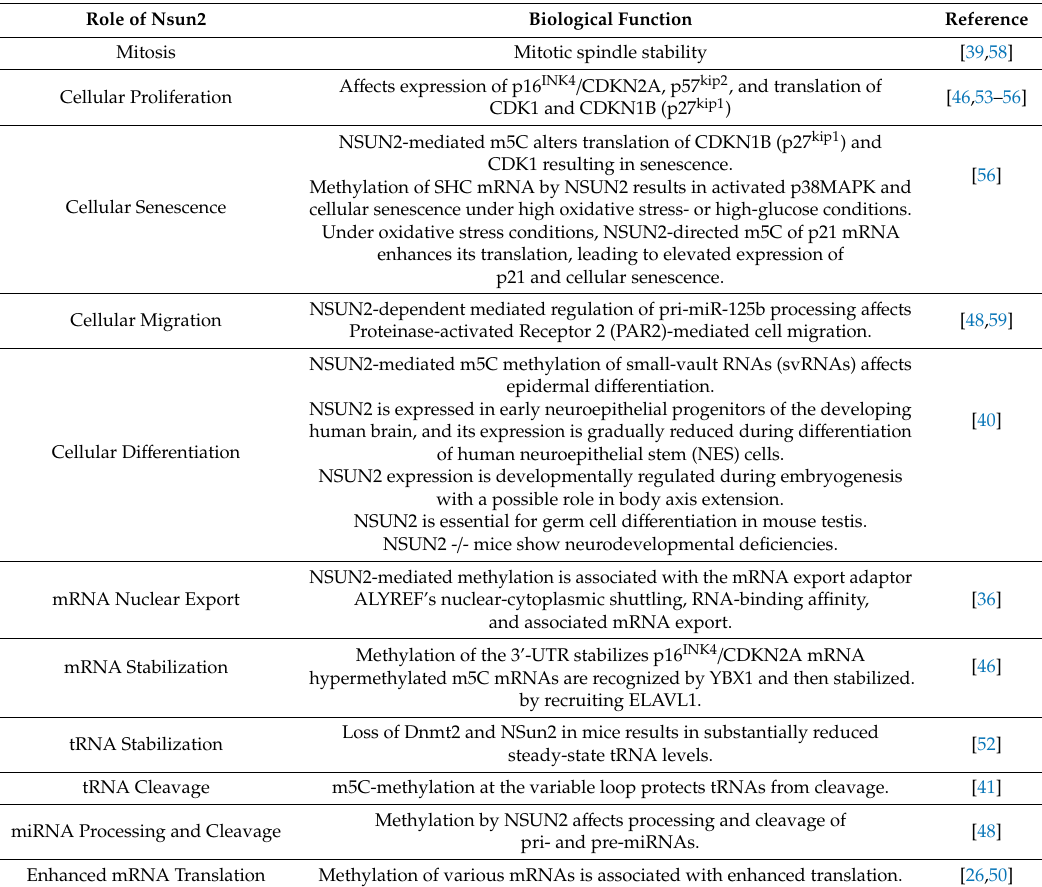
Table 1. Functional roles for NOL1 / NOP2 / SUN domain (NSUN2)-mediated RNA